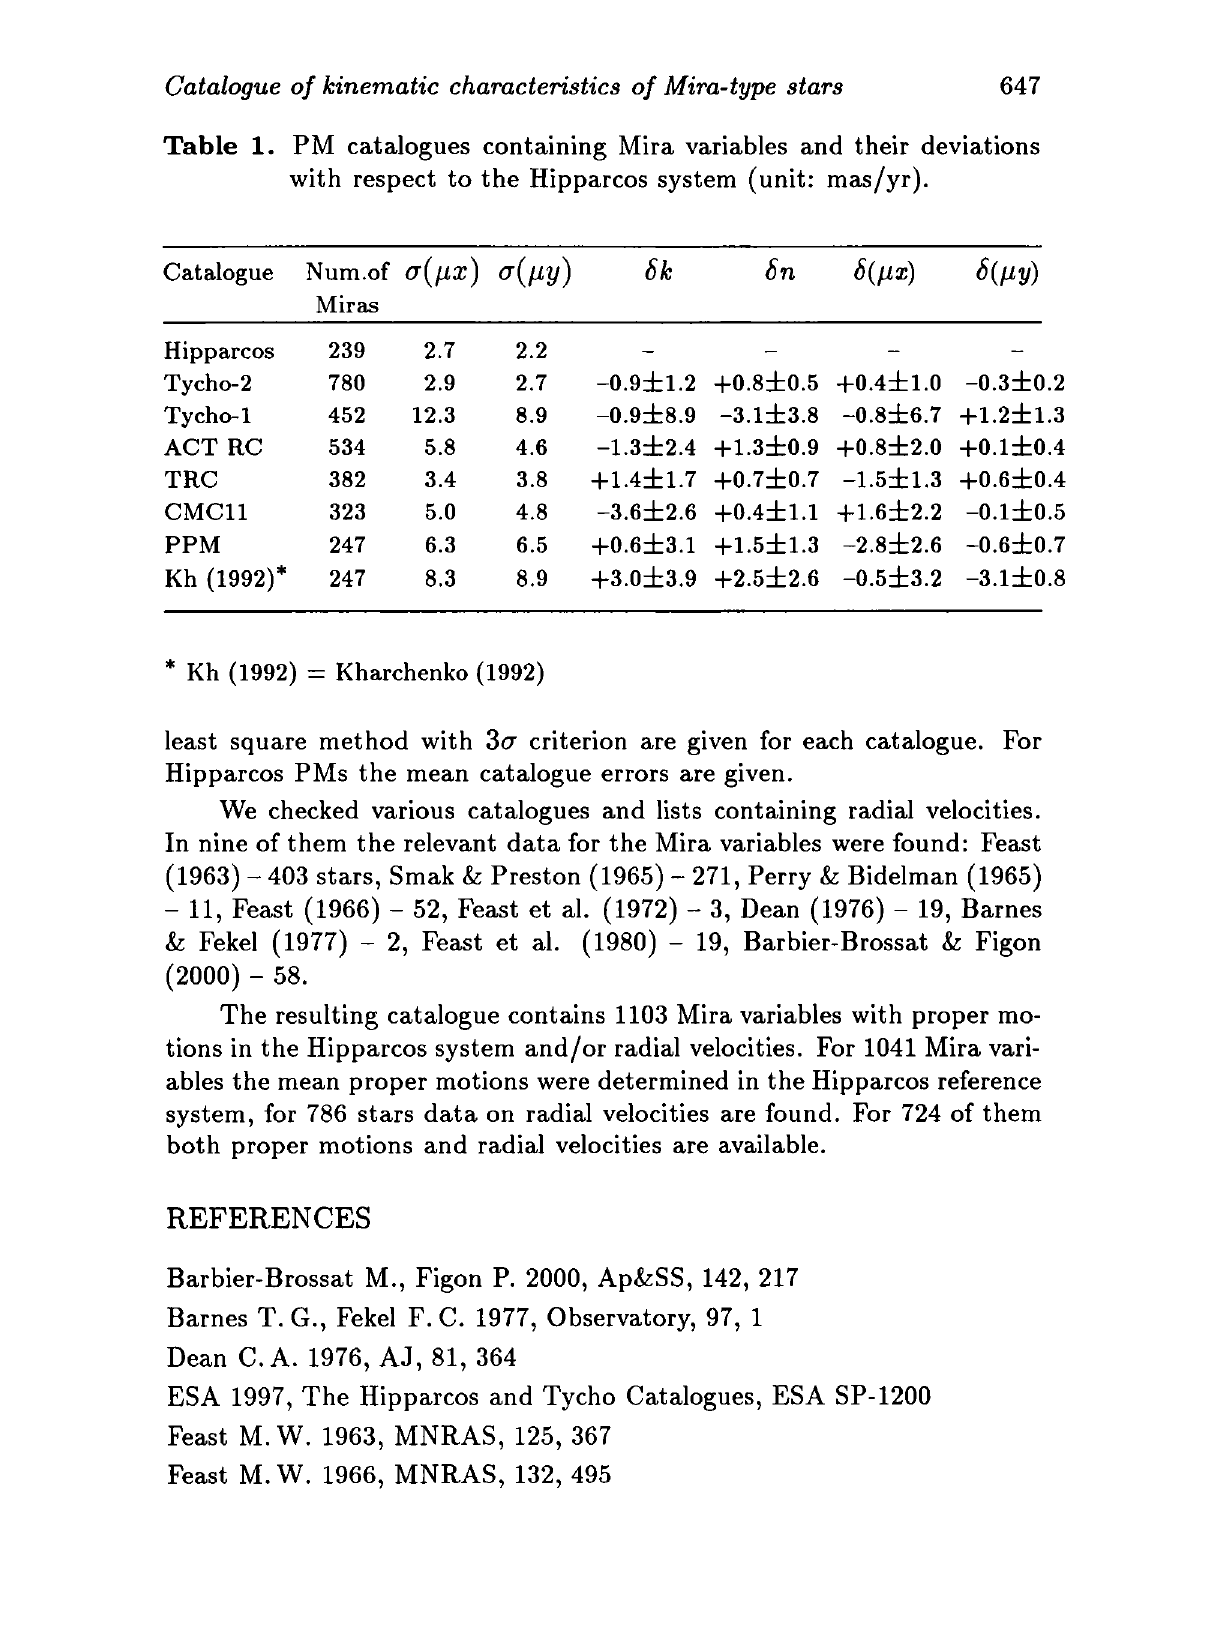
Table 1. PM catalogues containing Mira variables and their deviations with respect to the Hipparcos system (unit: